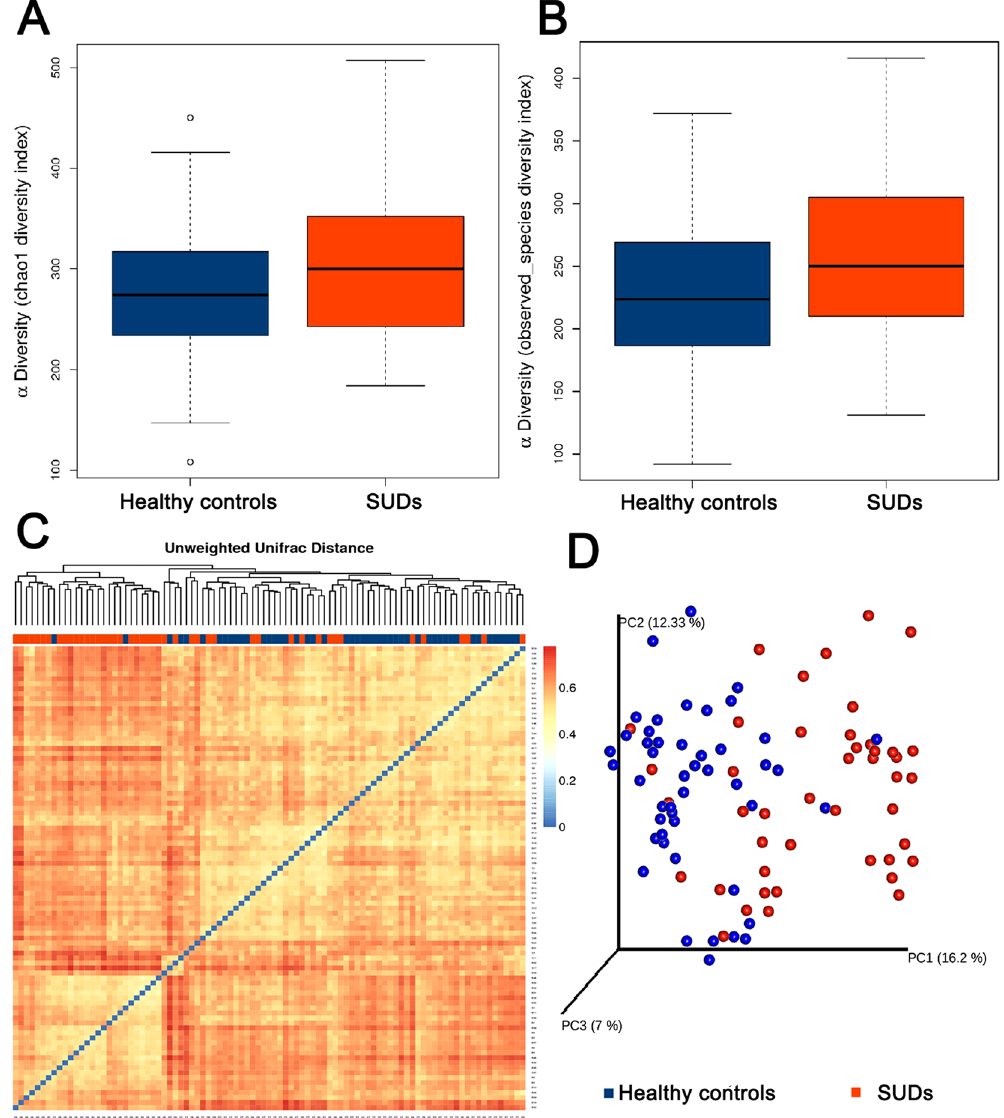
Figure 1. Analysis of alpha diversity in HC (blue) vs SUDs (orange) predicted diversity by Chao 1 estimator ( A ), p = 0.11 and observed species ( B ), p = 0.03. Beta diversity measures in SUDs vs HCs. ( C ) Hot map was performed basing on the unweighted-unifrac distances matrix using the R package “vegan”, orange for the SUDs and blue for the HCs. ( D ) Principal Coordinate Analysis (PCoA) and UPGMA tree of unweighted-unifrac distances of samples, blue for the HCs and red for the SUDs ( adonis test, R2 = 0.067, Pr ( > F) =